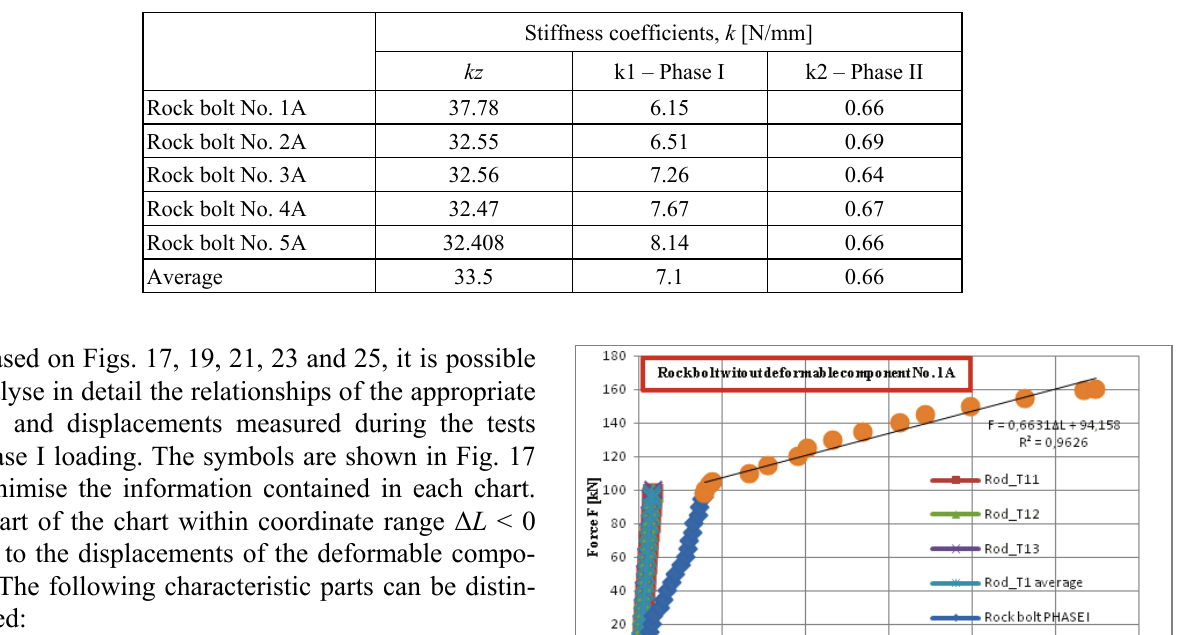
Table 4. The stiffness of the components of the rock bolt support and the rock bolt without increased deformability as a system composed of those elements